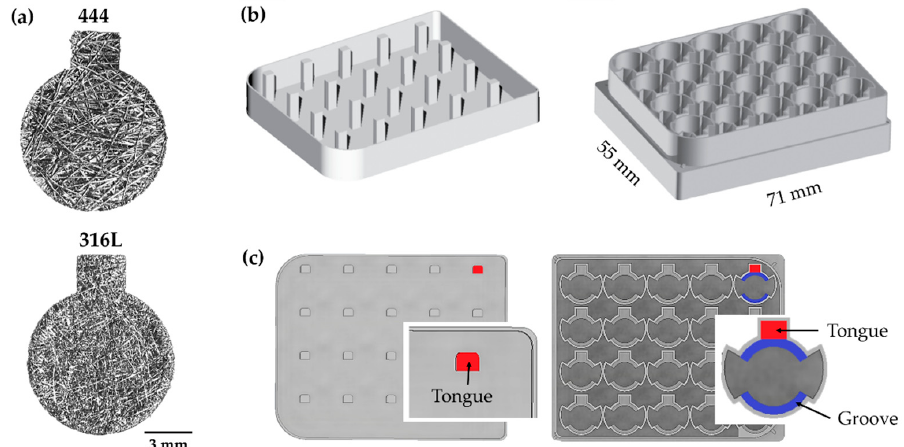
Figure 2. ( a ) 444 and 316L fiber networks, cut in a keyhole shape, for magnetic actuation. ( b , c ) Views of the lid and base of the bespoke culture plates. The lid contains tongues (red) to grip the samples, the latter are resting on grooves (blue) at the well